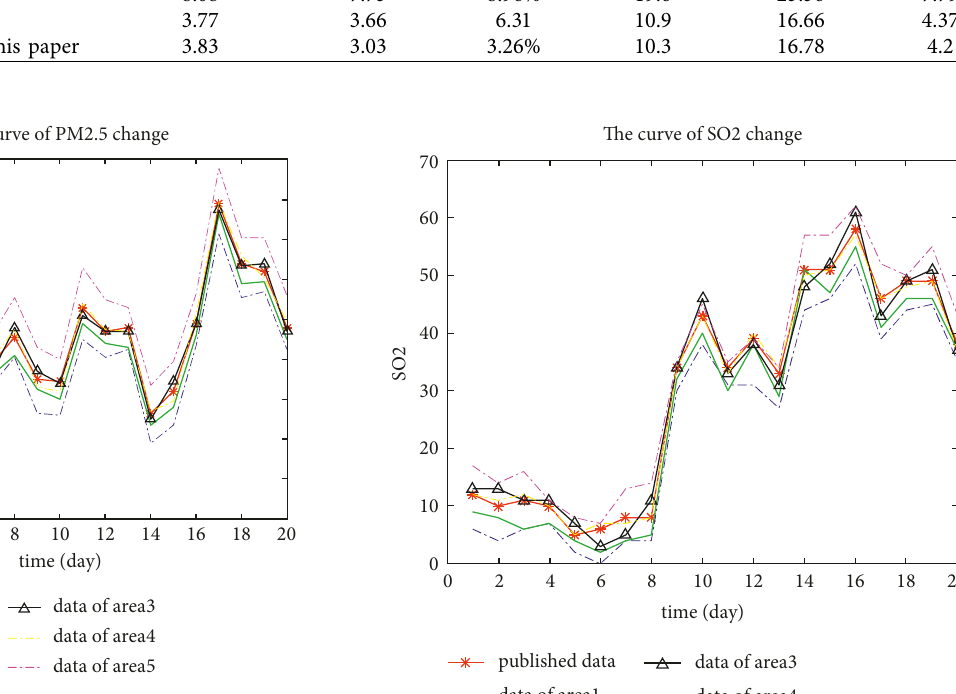
Figure 5: Curve of PM2.5 change in different task grid areas.